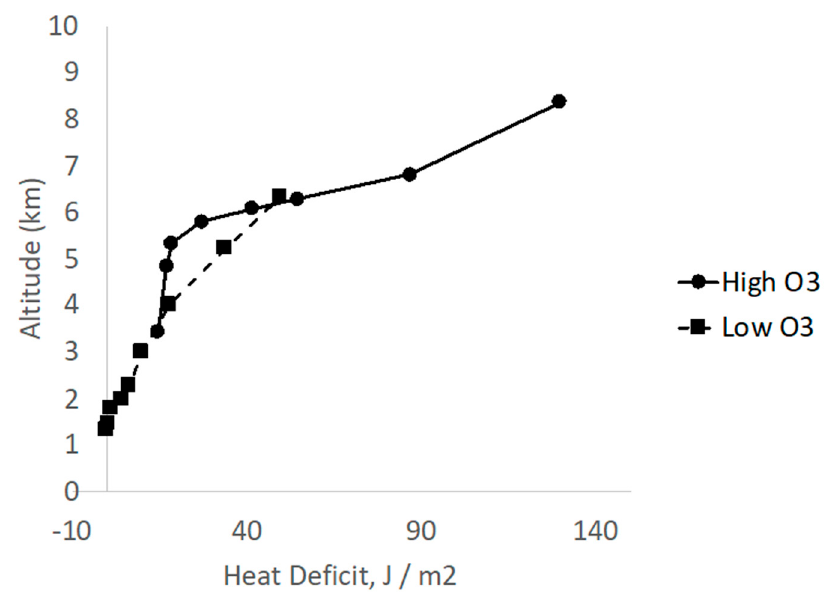
Figure 4. Heat deficit on high (5 June) and relatively low (6 June) ozone days for the ELP–CDJ region. The solid line with the filled circles is the heat deficit on the high ozone day of 5 June 2017 at around 1 p.m. The dashed line with the filled squares is the heat deficit on the low ozone day of 9 June 2017 at around 1 p.m.